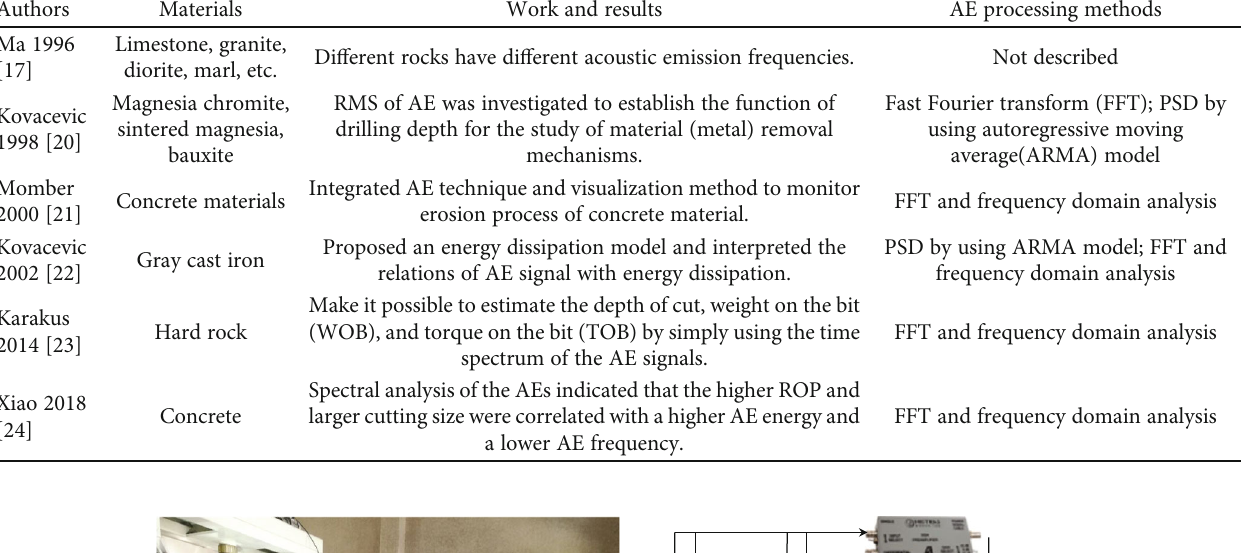
Table 1: Summary of earlier acoustic emission monitoring studies of rock-cutting.